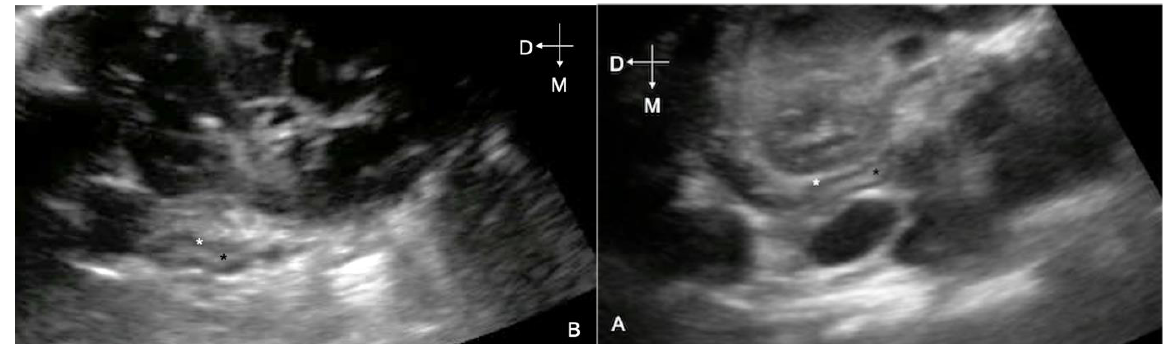
Figure 1. Ultrasound image of the right ( A ) and the left ( B ) adrenal gland of a healthy Thoroughbred foal. The figure illustrates the normal aspect of the adrenal glands; the cortex and medulla of each adrenal gland are indicated by white and black asterisks, respectively.